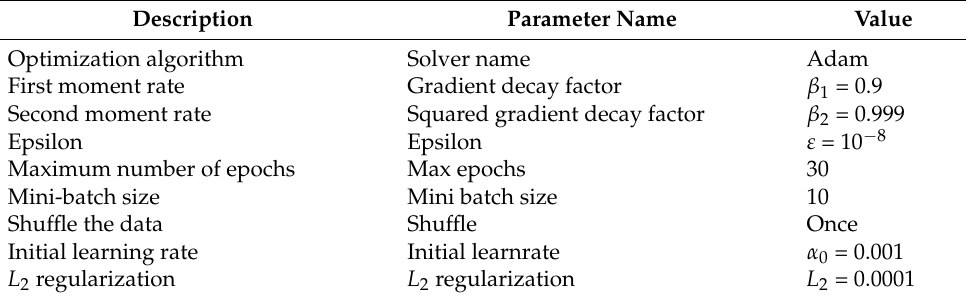
Table 6. Training parameters for the LSTM network.